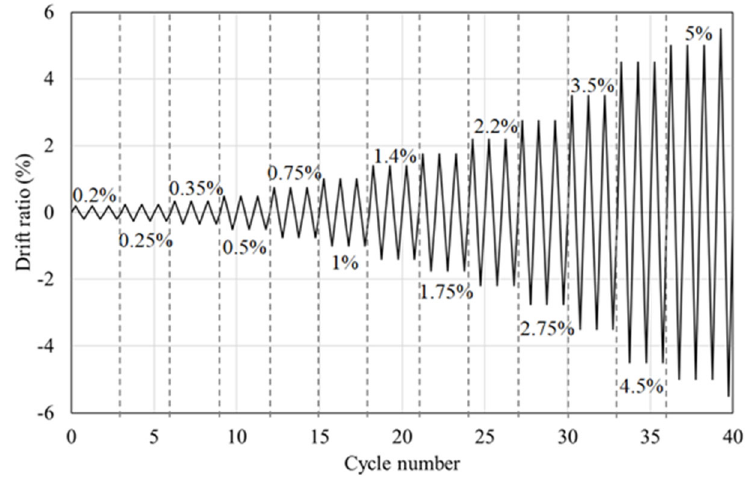
Figure 5. Loading Protocol.